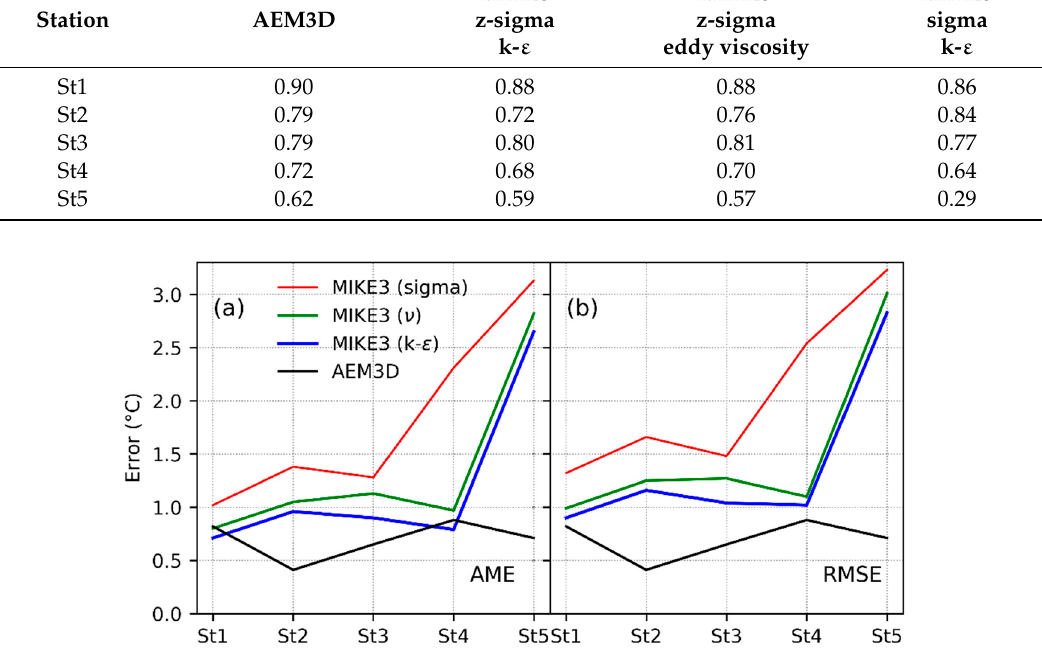
Figure 4. Simulation errors AME ( a ) and RMSE ( b ) for AEM3D and MIKE3.